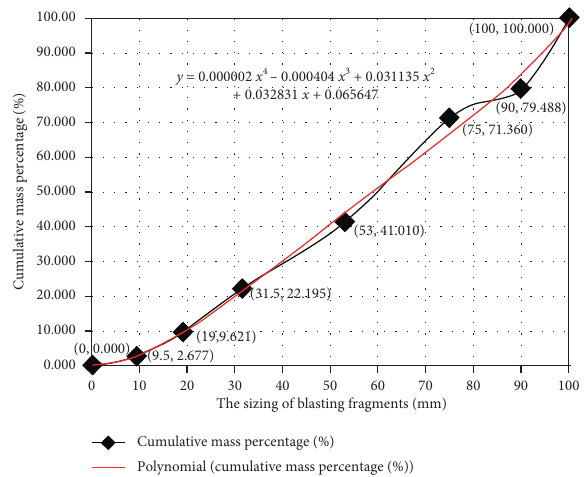
Cumulative mass percentage (%) Polynomial (cumulative mass percentage (%)) Figure 16: Relationship between cumulative mass percentage of blasting fragments and fragment size particle diameter of 73 ° wedge cutting.